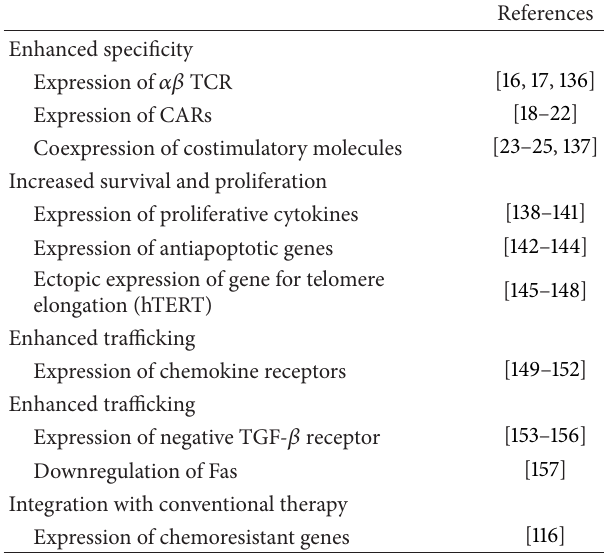
Table 3: Genetic modification of T cells to improve the efficacy of ACT for